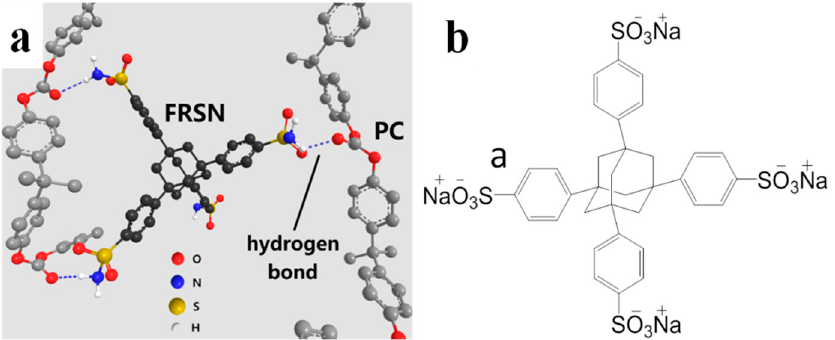
Figure 8. ( a ) A Schematic of hydrogen bonds formed between the flame retardant FRSN and PC, and ( b ) structure of flame retardant AS 4 .